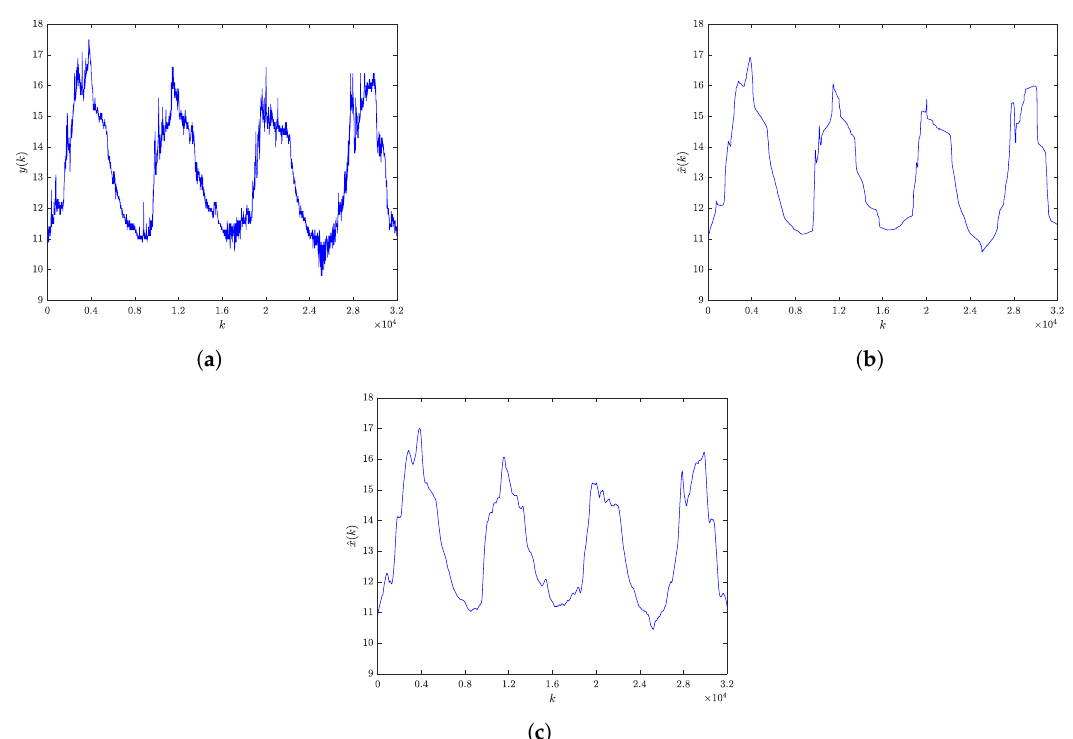
Figure 9. Sea temperature: ( a ) Noisy measured signal. ( b ) RBF-RICI filtered signal. ( c ) Savitzky–Golay filtered signal.